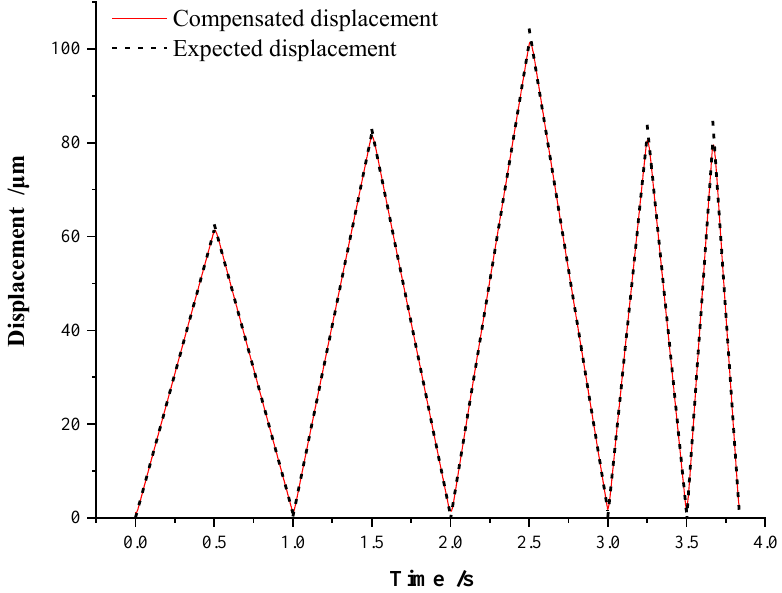
Figure 13. Hysteresis compound compensation.